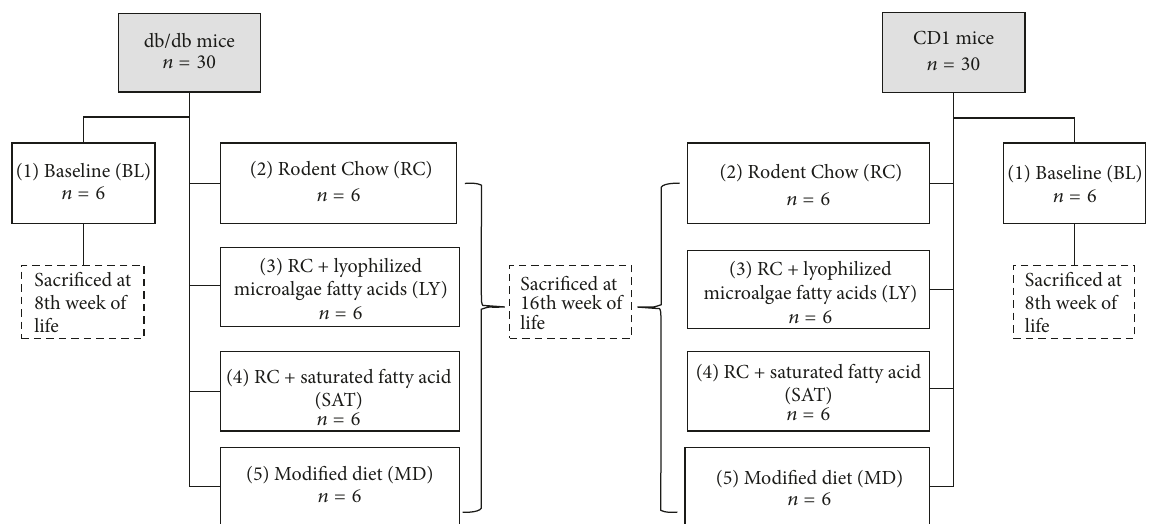
Figure 1: Experimental groups for both